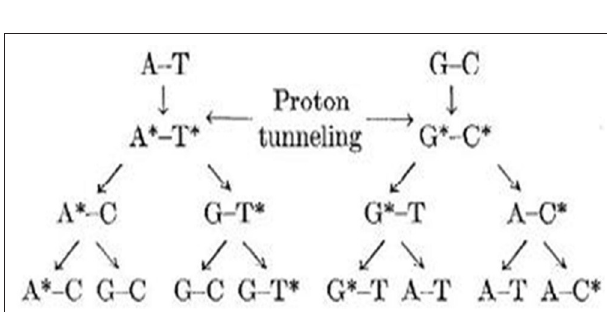
FIGURE 3 | Schematic representation of various possible rare tautomeric states of Watson–Crick (WC) base pairs.